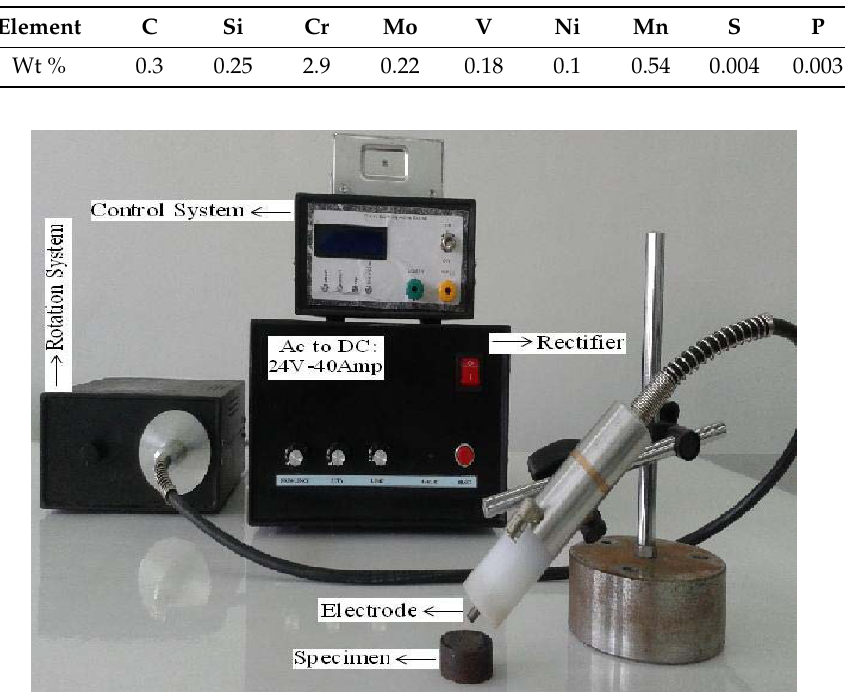
Figure 1. Micro ‐ Electro Welding (MEW) device made during this study. Figure 1. Micro-Electro Welding (MEW) device made during this